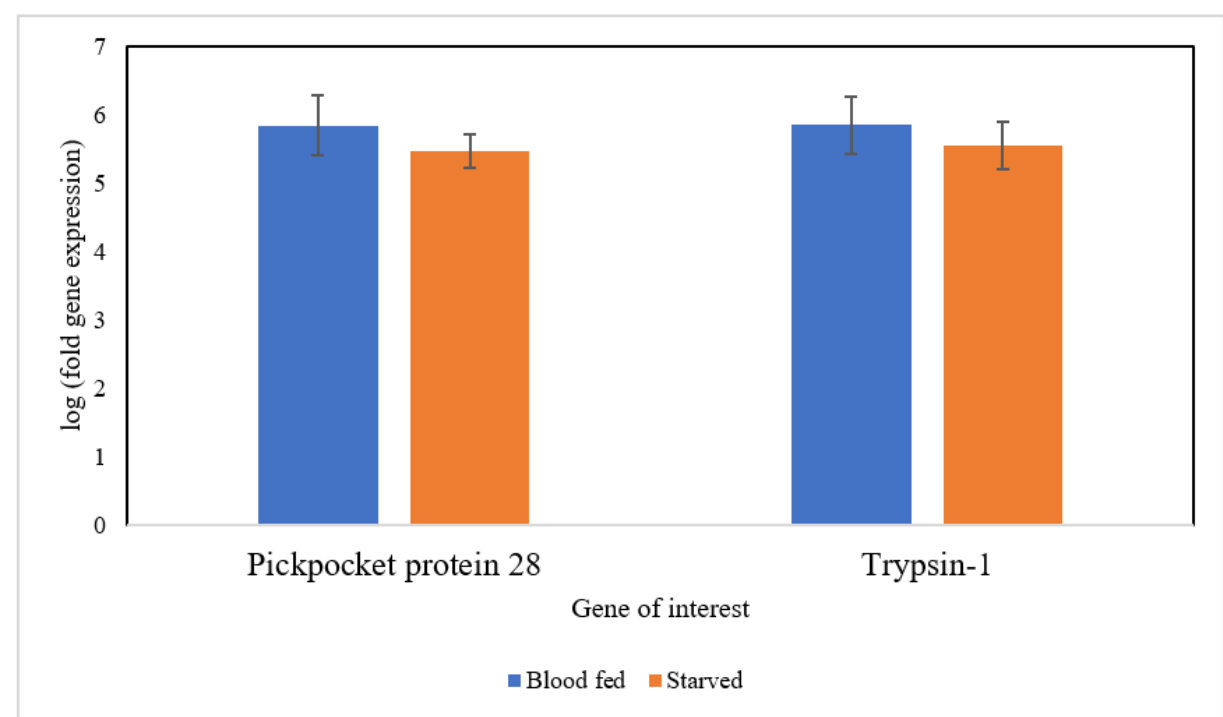
Figure 3. qRT-PCR analysis of two genes: Pickpocket protein 28 and Trypsin-1.